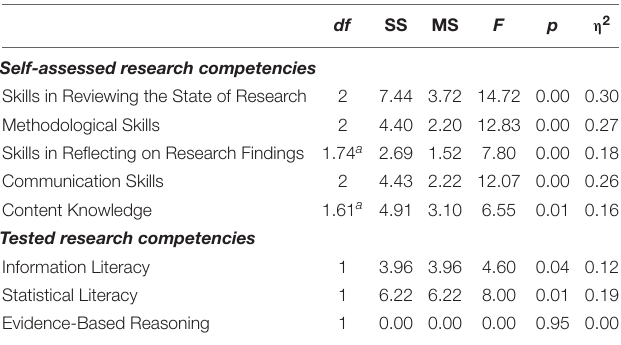
df = degrees of freedom; SS = sum of squares; MS = mean square; F = F-statistic; p = level of significance; η 2 = effect size. a Huyhn-Feldt corrected